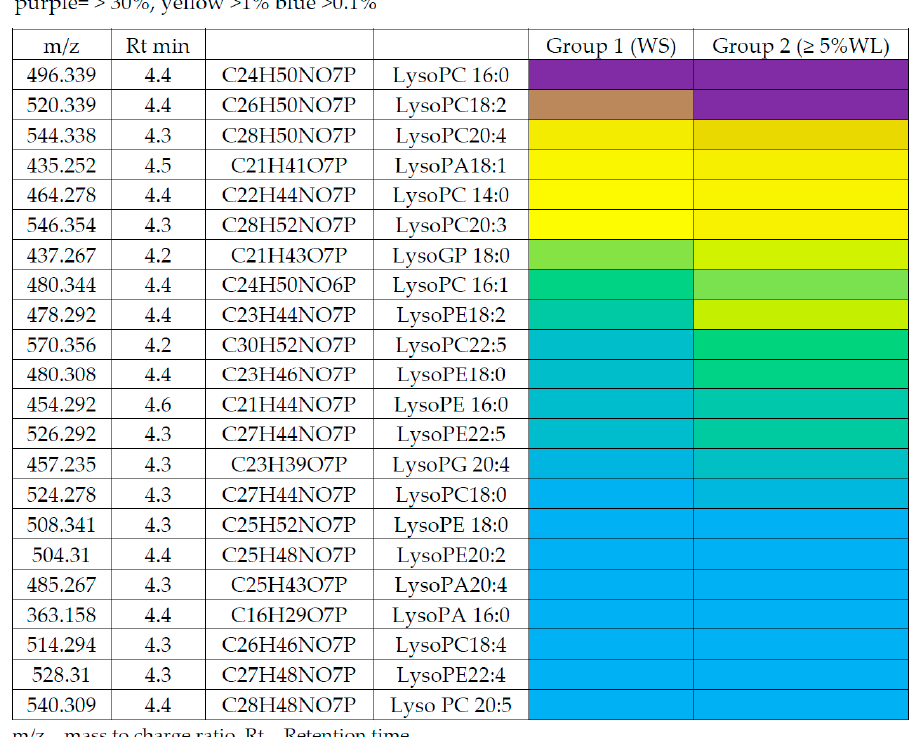
Figure 2. Heat map showing relative levels of lysolipids.